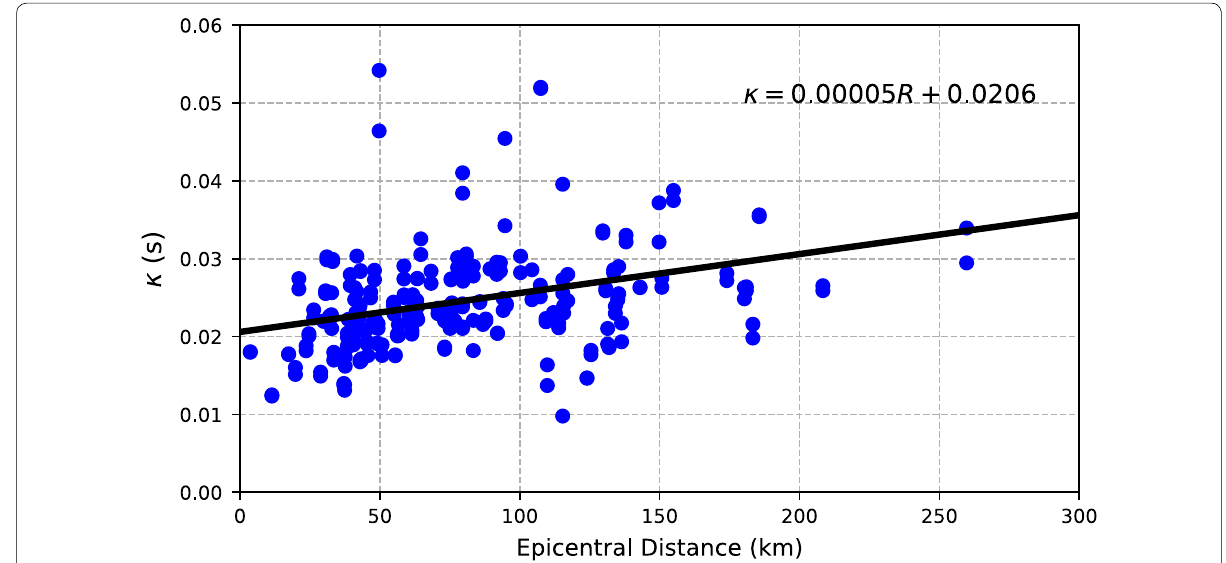
Fig. 3 Distance dependence of horizontal kappa ( κ ). The regression line uses standard linear